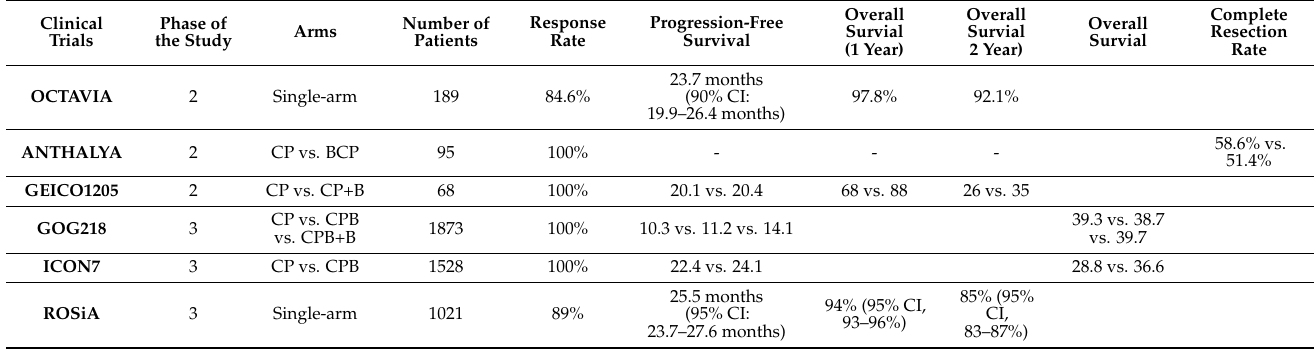
Table 1. A summary of the clinical trials retrieved in the